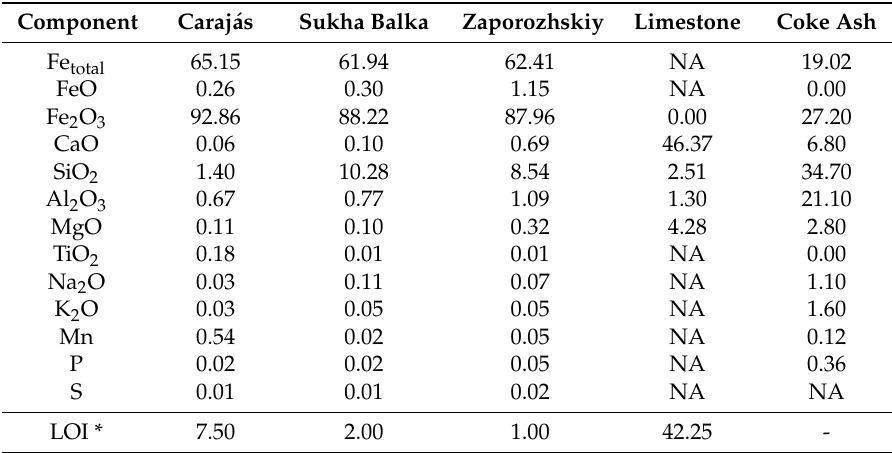
Table 1. Chemical composition of the raw materials, dry wt